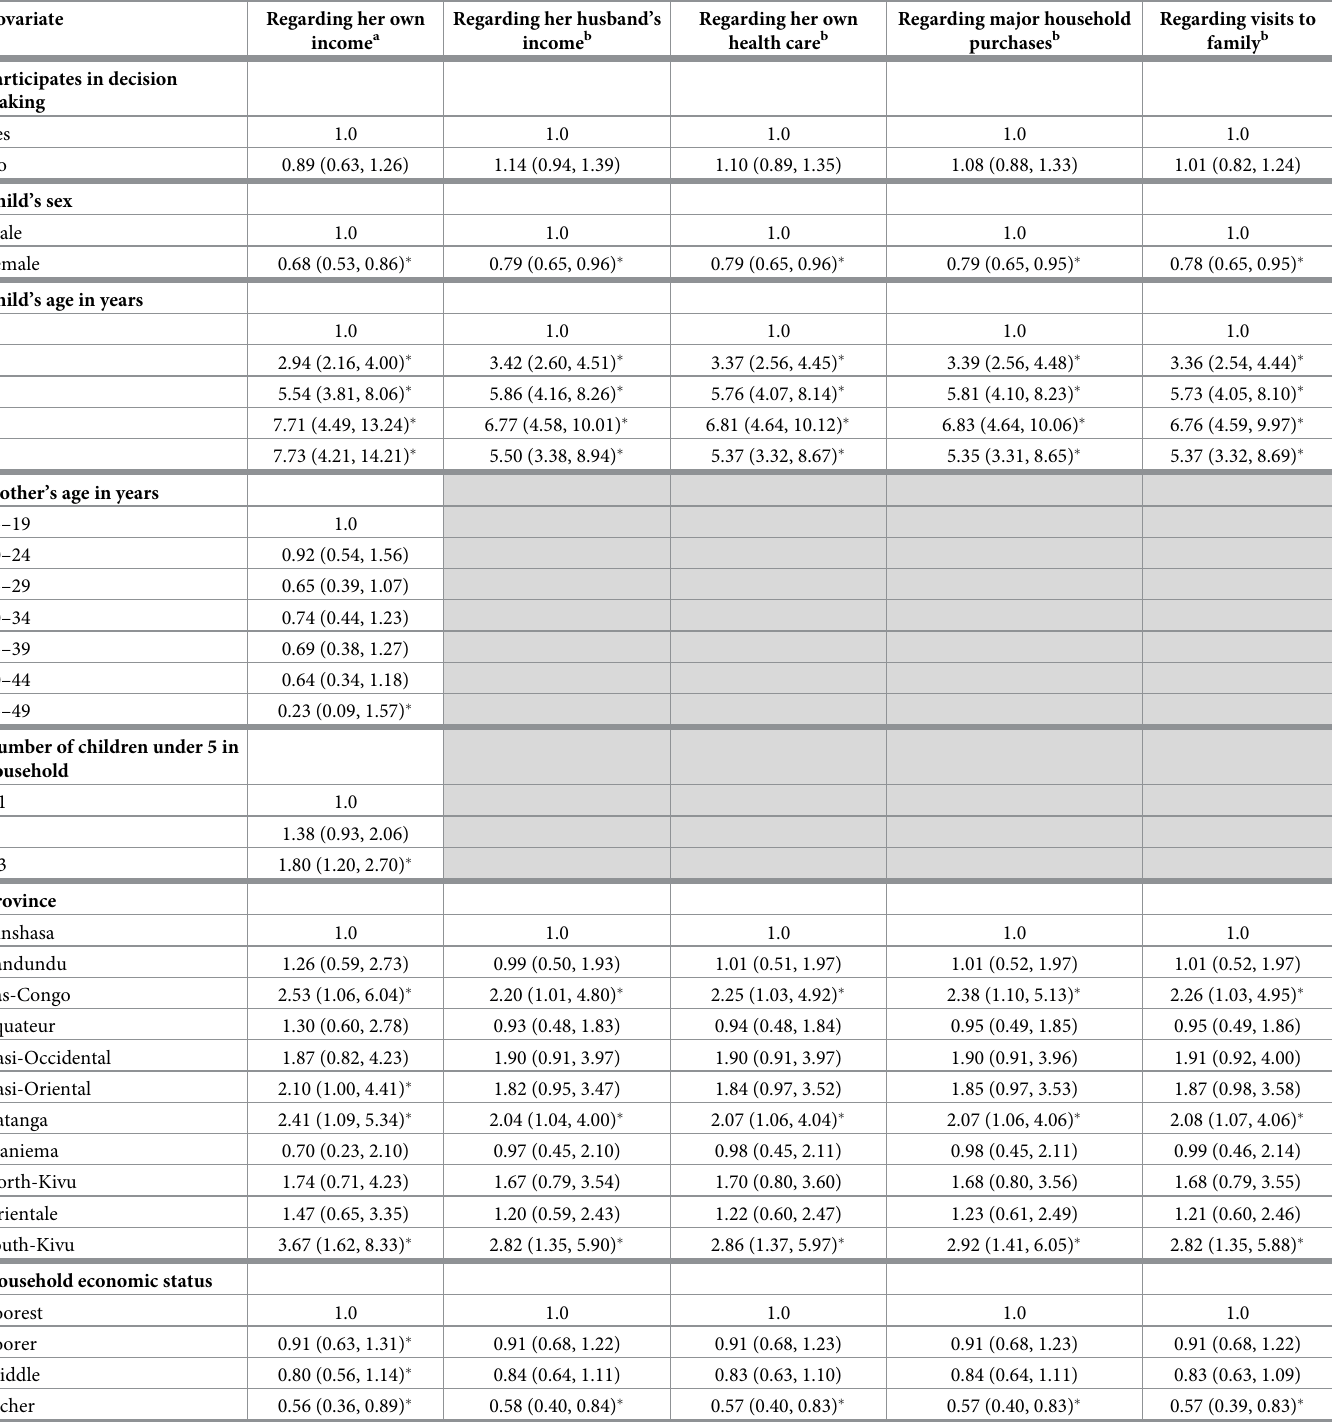
Table 3. Adjusted odds ratios for the outcome of